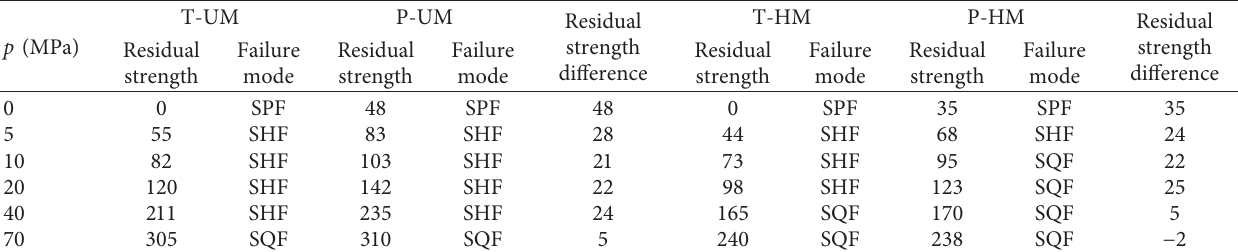
Table 4: Residual strengths of mortar specimens (MPa).